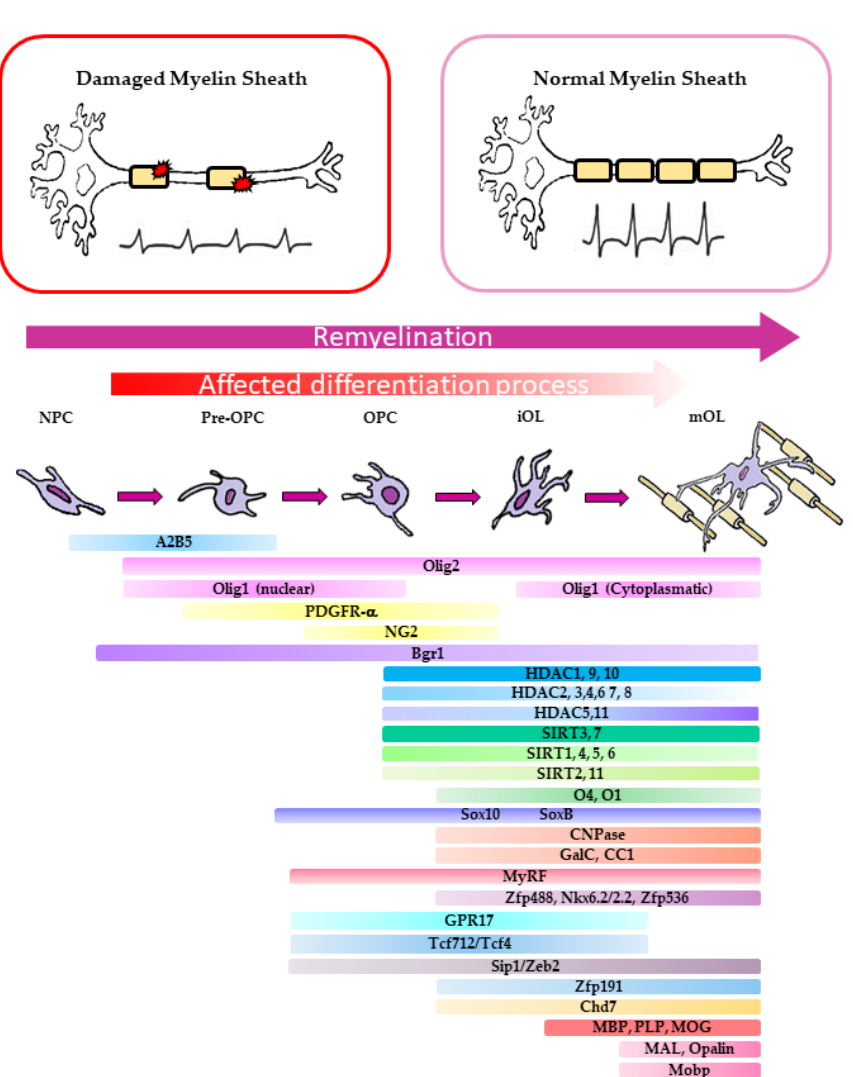
Figure 1. Remyelination is due to new oligodendrogenesis and differentiation of OPCs to mature and myelinating OLs. The remyelination process is activated in the adult brain during the processes of myelin turnover, myelin plasticity, or in the event of damage. This process involves oligodendrogenesis, the activation of neural progenitor cells (NPCs), proliferation and differentiation to mature OLs (mOL), or reactivation of resident oligodendrocyte precursor cells (OPCs), quiescent from the phase of embryonic brain development, which can differentiate into mature and myelinating OLs. This complex process of differentiation, driven by as yet not fully understood mechano-biological signaling, decreases with demyelinating disease progression and during ag- ing. There is a strong effort to isolate drugs able to restore the remyelination process, starting from both the OPC and NPC remyelinating pools. The numerous studies carried out have characterized the main factors, listed in the figure, that distinguish each development phase of the OL lineage.